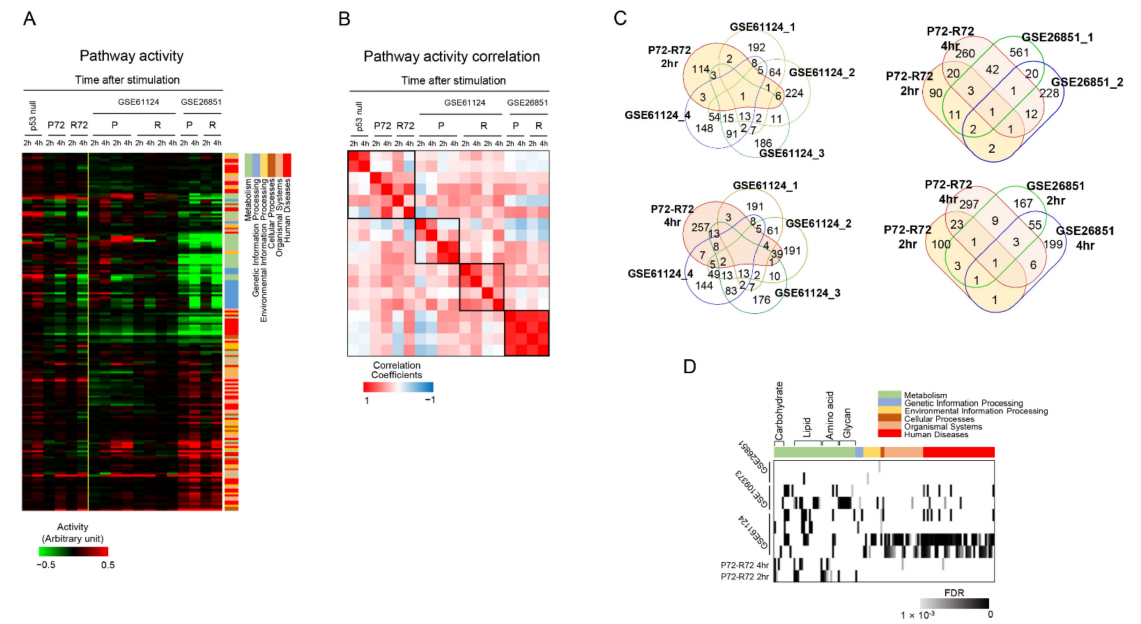
Figure 6. Analysis of external public datasets. ( A ) Pathway activity from external datasets and our samples were measured and clustered. Red and green indicate high and low activity levels, respectively, as indicated by the scale bar. Six functional categories including each pathway are indicated by color next to the figure. In GSE61124, P72 or R72 was present for each of the two cell types, respectively. ( B ) Correlation among samples were measured according to activity level of pathway. Red and blue indicate high and low activity levels, respectively, as indicated by the scale bar. ( C ) The distribution of core DEGs selected from the external data sets was compared with those selected from our P72 and R72 cells. In GSE61124, four types of core DGEs were isolated from P72 and R72 at 4 h after stimulation for each cell type, and in GSE26851, two types of core DGEs were isolated for each cell type. The core DEGs in our experiments are highlighted in color. ( D ) Pathways associated with core DEGs selected from external datasets were compared between samples. Intensity in black indicates statistical significance as shown in the scale bar